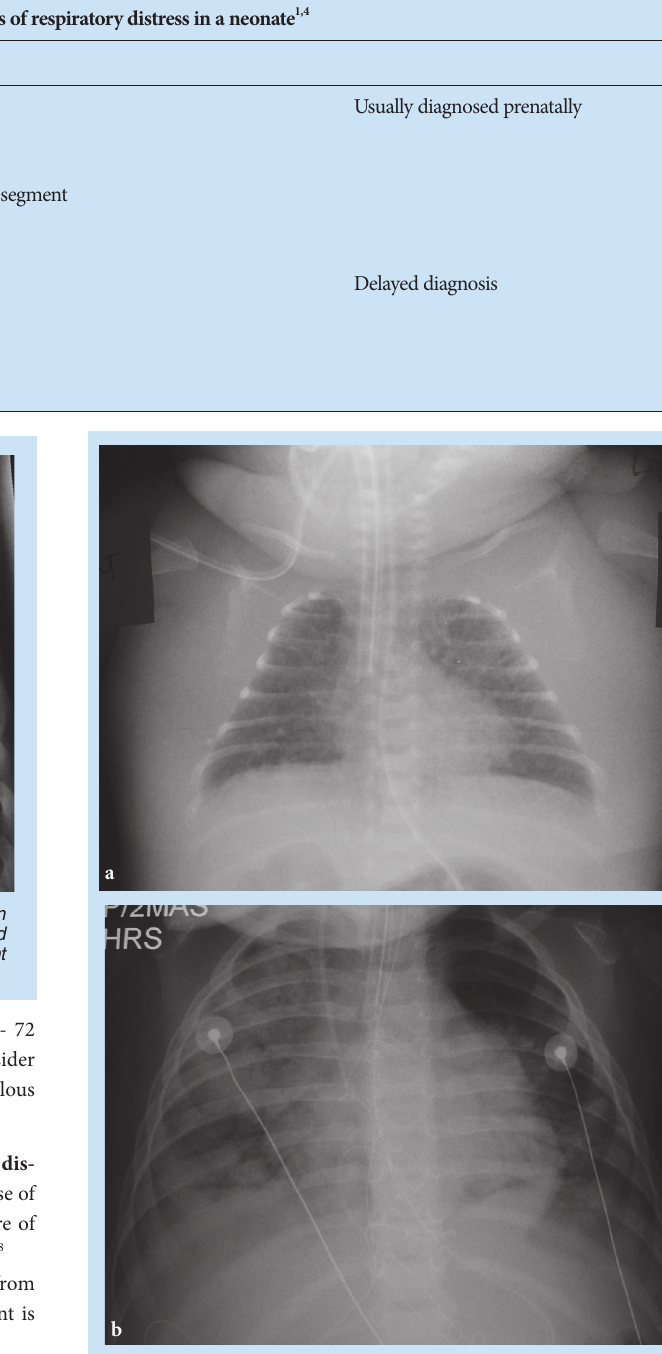
Fig. 14. Complications of intravascular fluid therapy. (a) Fluid-overload using an intravascular catheter may result in increased third space fluid manifesting here as massive soft tissue thickening around the chest. There should be very little soft tissue in a neonate. The ETT is noted to have its tip low in the airway. (b) Bilateral asymmetrical peri-hilar airspace disease is consistent with pul- monary oedema as a result of fluid overload via the central catheter. This was confirmed as it resolved after diuretic therapy. The ETT in this patient is low in the